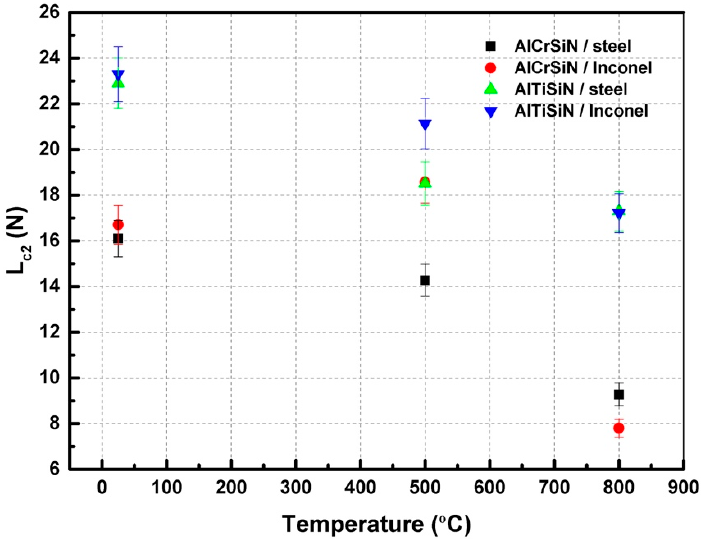
Figure 4. Critical load as a function of temperature of the thermal treatment.